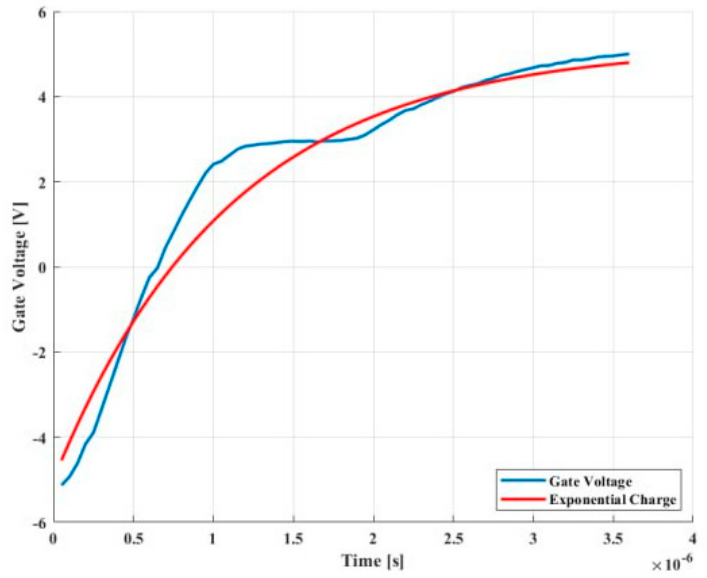
Figure 12. Exponential charge approximation of the rising gate voltage.